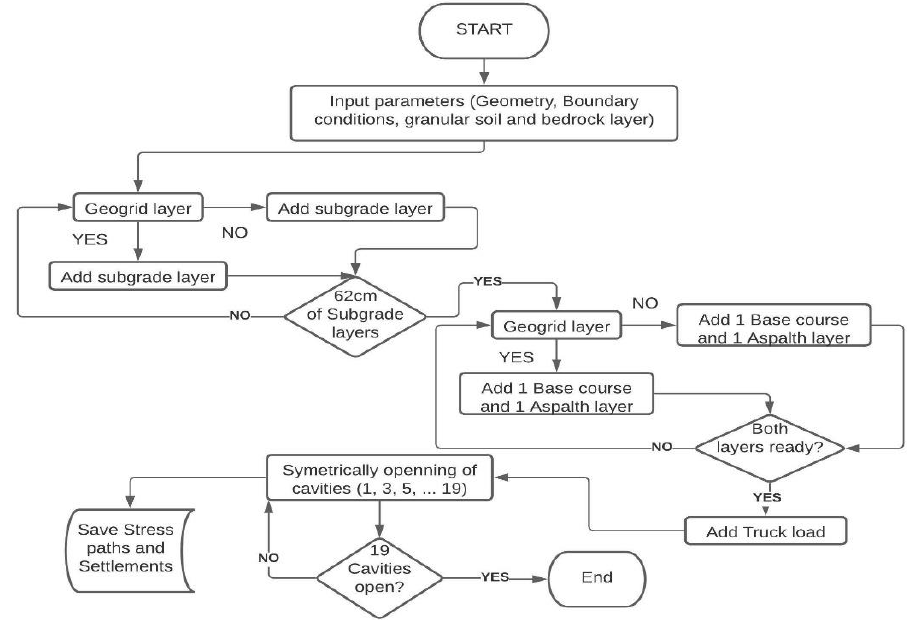
Figure 4. Flow chart of the numerical modelling of a road reinforcement with geogrids in a karst terrain.